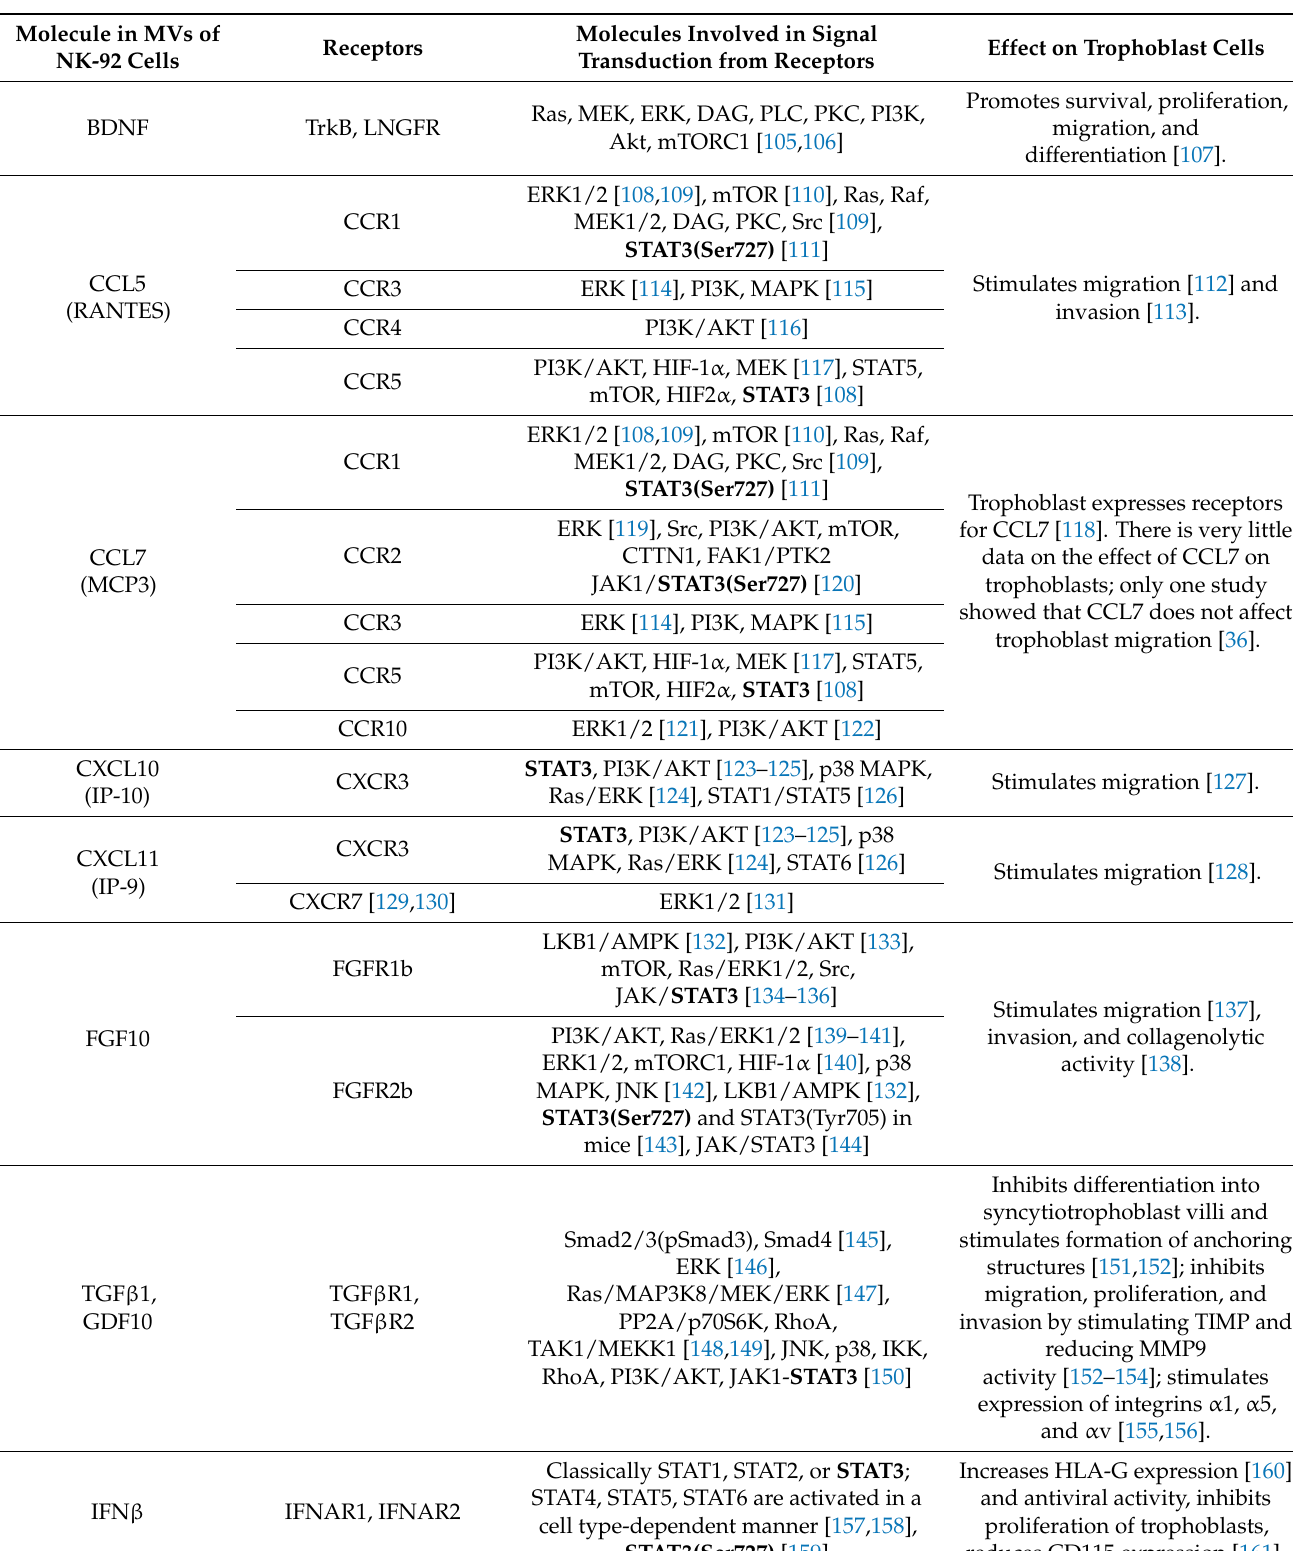
Table 2. Some molecules included in the composition of NK-92 cell MVs (according to mass spec- trometry data [83,104]) and possible signal transduction pathways that involve the phosphorylation of intracellular signaling